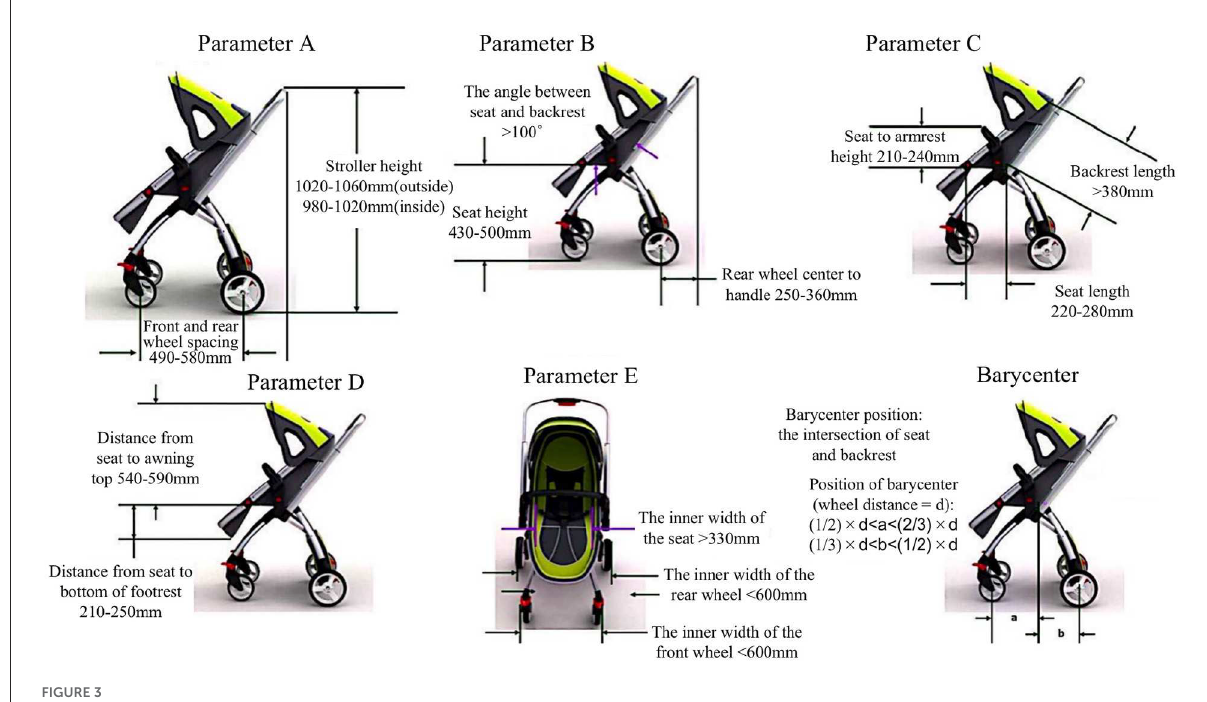
FIGURE3 Standard size range of the baby stroller.